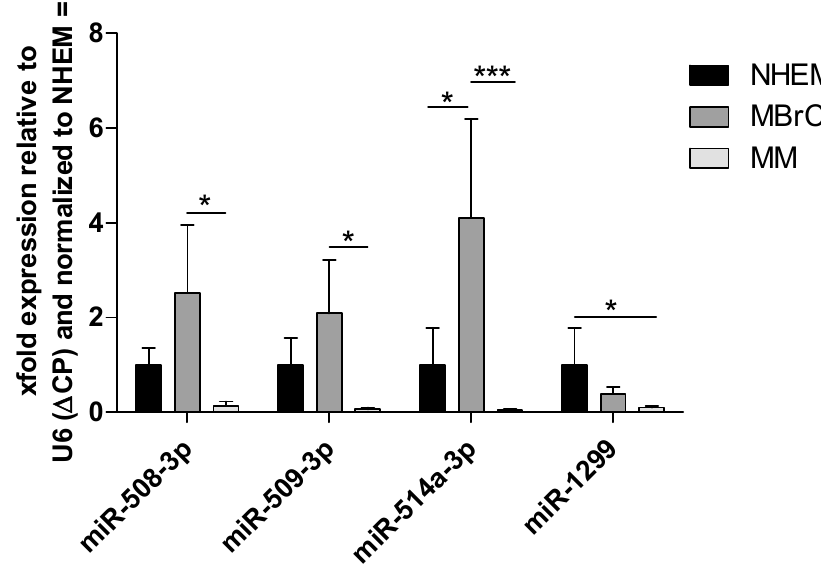
Figure 5. QRT-PCR shows a strong downregulation of miRNAs of the miR-506–514 cluster and miR-1299. Analysis of miR-508-3p, miR-509-3p, miR-514a-3p, and miR-1299 expression in normal human epidermal melanocytes (NHEM), melanoblast-related cells (MBrC), and at least 6 different melanoma cell lines (MM) via qRT-PCR. Bars represent mean + SEM, statistical significance was calculated using one-way ANOVA and subsequent Tukey’s Multiple Comparison Test with Δ CP values before normalization to NHEM and is indicated as * p ≤ 0.05 and *** p ≤ 0.001. Significant downregulation of miR-508-3p, miR-509-3p, and miR-514a-3p in melanoma cell lines compared to MBrCs can be observed, confirming the RNA-seq expression results. In addition, we could also show a strong downregulation of miR-1299. These data support the reliability of our RNA-seq analysis.